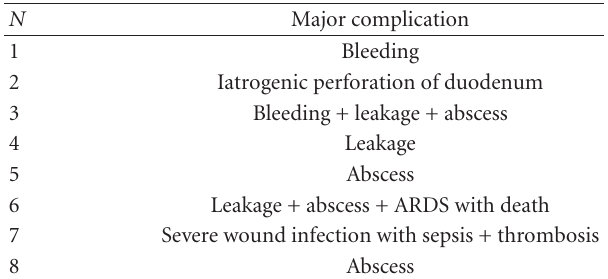
Table 4: Major complications ( n =